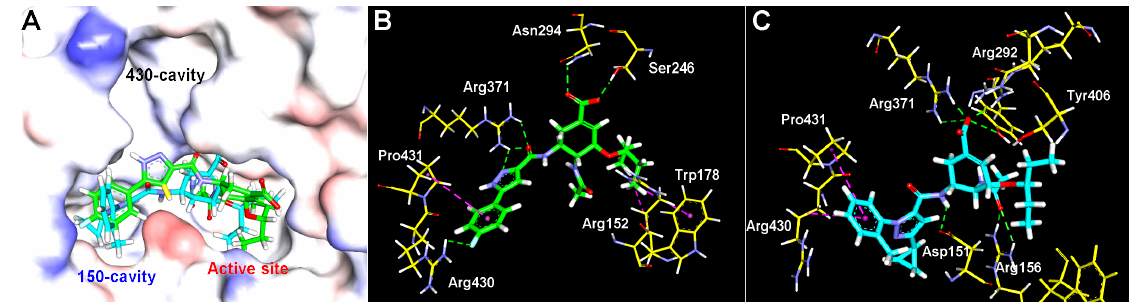
Figure 4. ( A ) Binding positions of compounds 12c (green) and 26b (cyan) to NA (PDB: 2HU0); Detailed interactions of 12c ( B ) and 26b ( C ) with NA: Hydrogen/ionic bonding interactions (green) and hydrophobic interactions (magenta). Table 4. Hydrogen bonding interactions between NA (PDB: 2HU0) and compounds 12c and 26b . H-Bonding between NA and 12c H-Bonding between NA and 26b Hydrogen Bonds